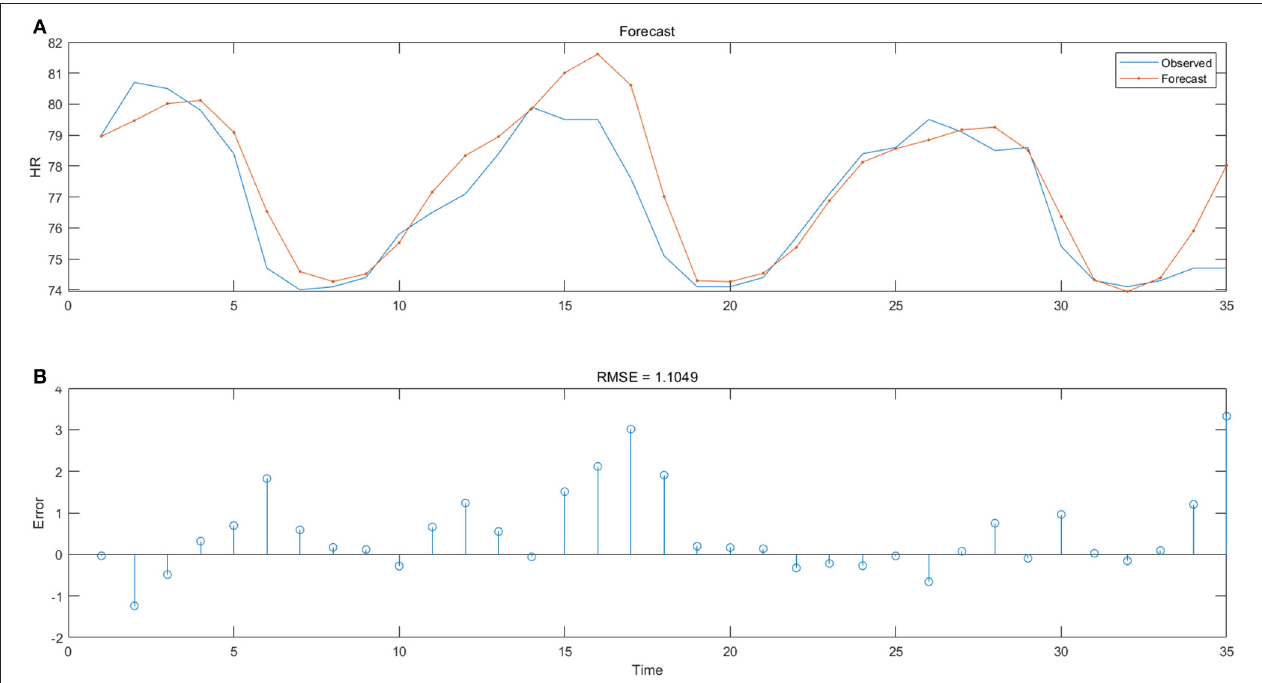
FIGURE 8 | (A) HR prediction results and (B) RMSE